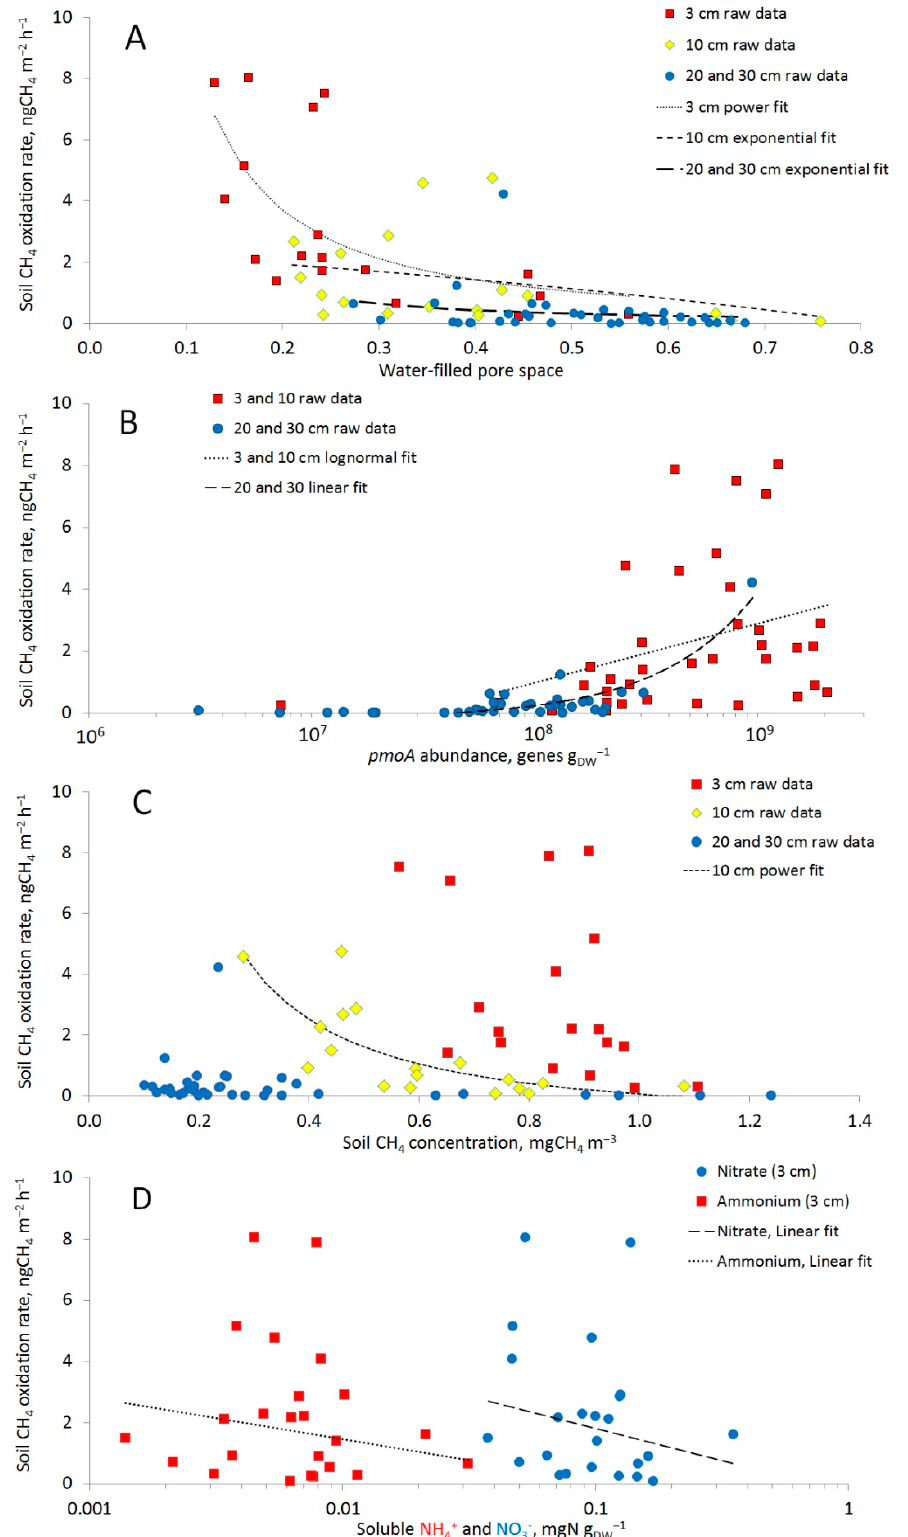
Figure 4. Depth-specific relationships between soil methane oxidation rate and ( A ) water-filled pore space, ( B ) methanotroph abundance, ( C ) soil methane concentration and ( D ) soluble NH 4+ and NO 3 − content. Performance of models is presented in Table S3. Note the logarithmic scale of the X -axis ( B , D ).